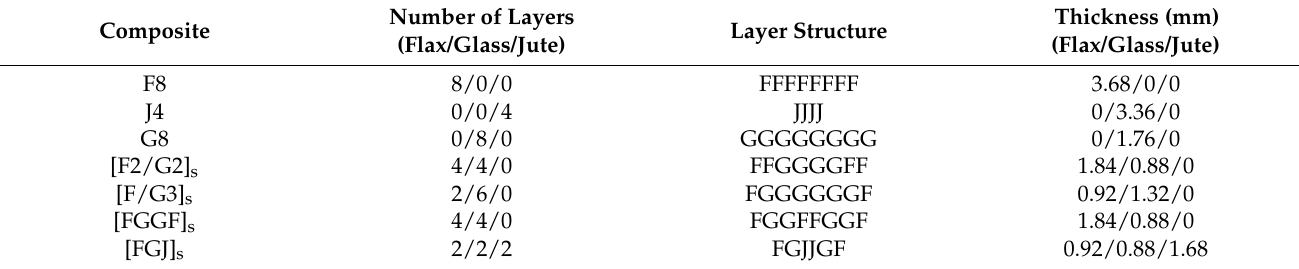
Table 2. The parameters of different layer sequence.